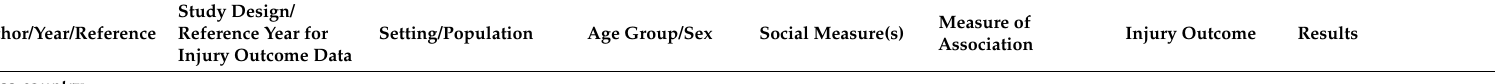
Table 3. Descriptive characteristics of studies on injury inequalities not investigating changes over time, cross-country, and